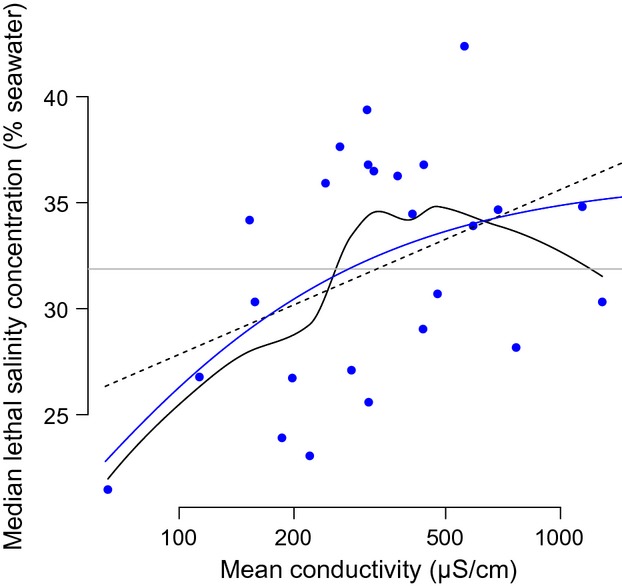
Functional relationship between electrical water conductivity and salinity tolerance in individual populations of An. coluzzii and An. gambiae from Central Africa. Trend lines show competitive regression models fitted to the data, whose parameters are presented in Table7. The solid continuous black curve represents a loess smoother fitted to the data in order to extract the general shape of the functional relationship between the two variates. The blue asymptotic curve is the most parsimonious model based on the AIC. The other competitive models are shown as a dashed black (linear model) and horizontal grey (null model) lines.